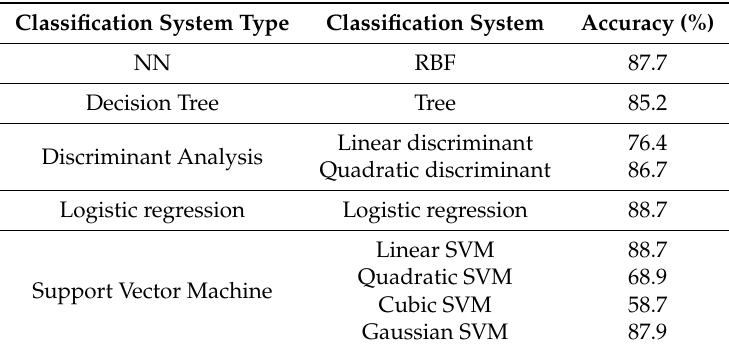
Table 6. Parameters of signals measured for each